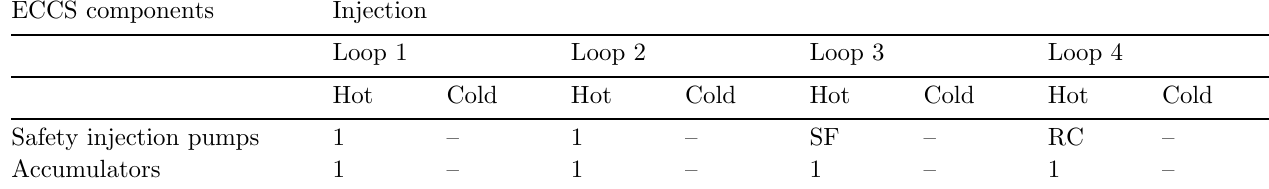
Table 2. Availability of the ECCS components